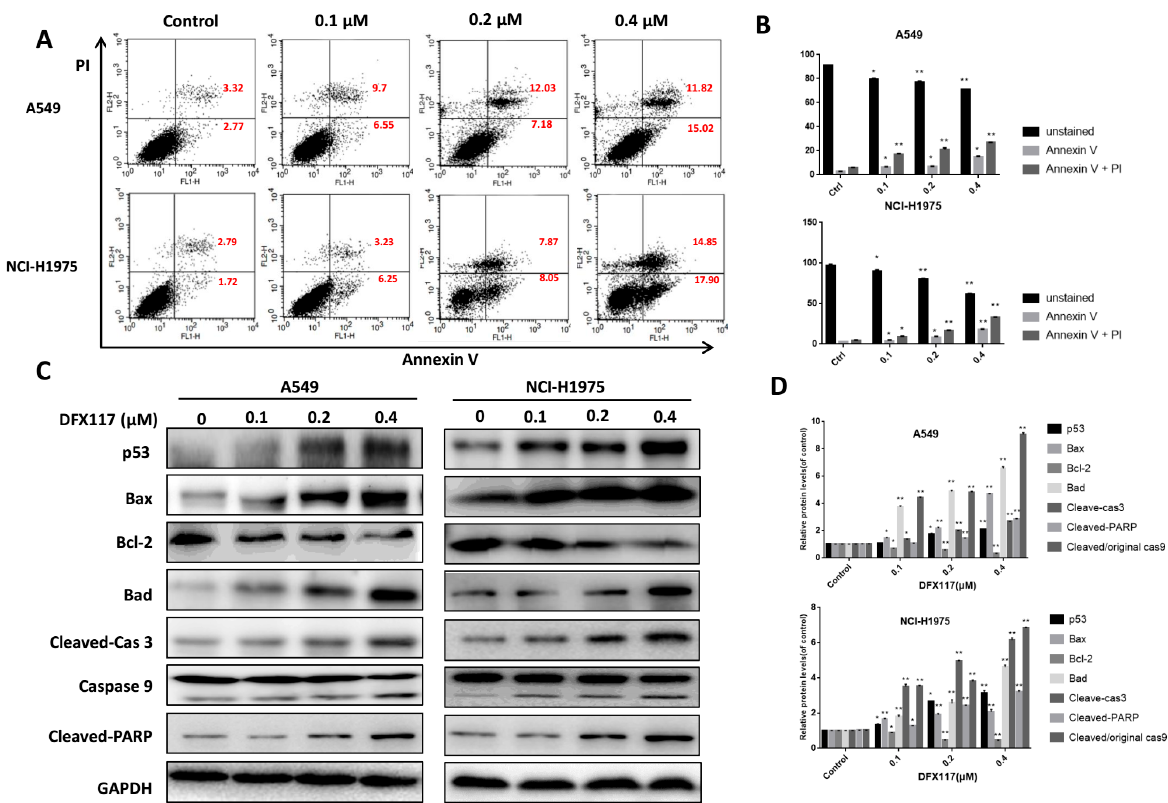
Figure 5. DFX117 induced apoptosis in lung cancer cells. ( A ) Cell apoptosis was analyzed by flow cytometric analysis after Annexin V-FITC/PI staining. Cells were collected and centrifuged at 2000 rpm for 10 min after DFX117 treatment at various concentrations for 48 h. ( B ) The number in the right quadrant of each panel represents the percentage of Annexin V-positive cells. ( C , D ) The effect of DFX117 on the induction of apoptosis was also analyzed by Western blot in A549 and NCI-H1975 cells. The changes in corresponding protein expression levels were quantified using Image J. Each bar represents the mean ± SEM ( n = 3). * p < 0.05 or ** p < 0.01 was considered statistically significant compared with the corresponding control values.